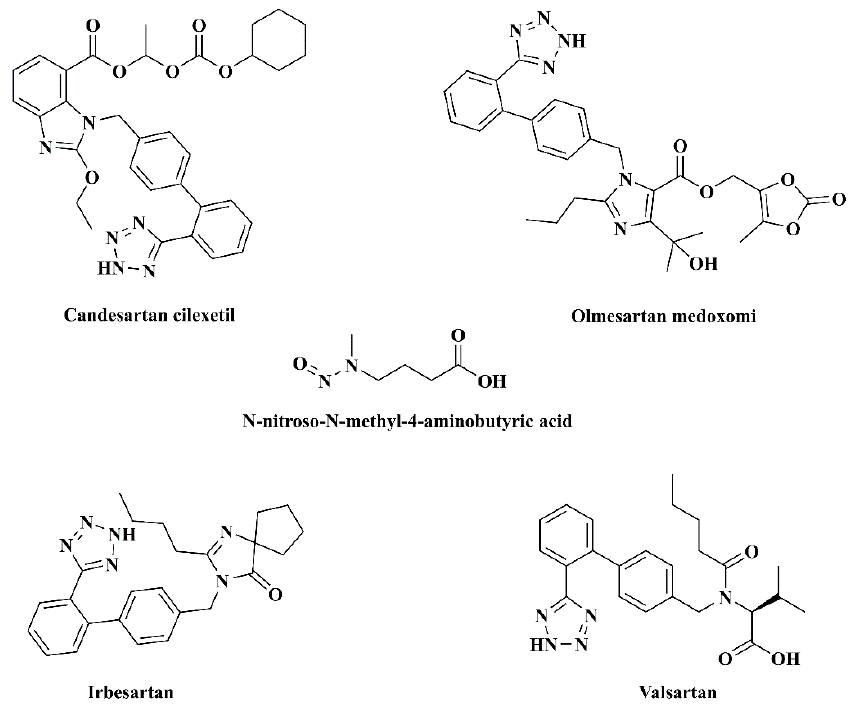
Figure 1. Molecular structures of NMBA and four sartan substances in this study.